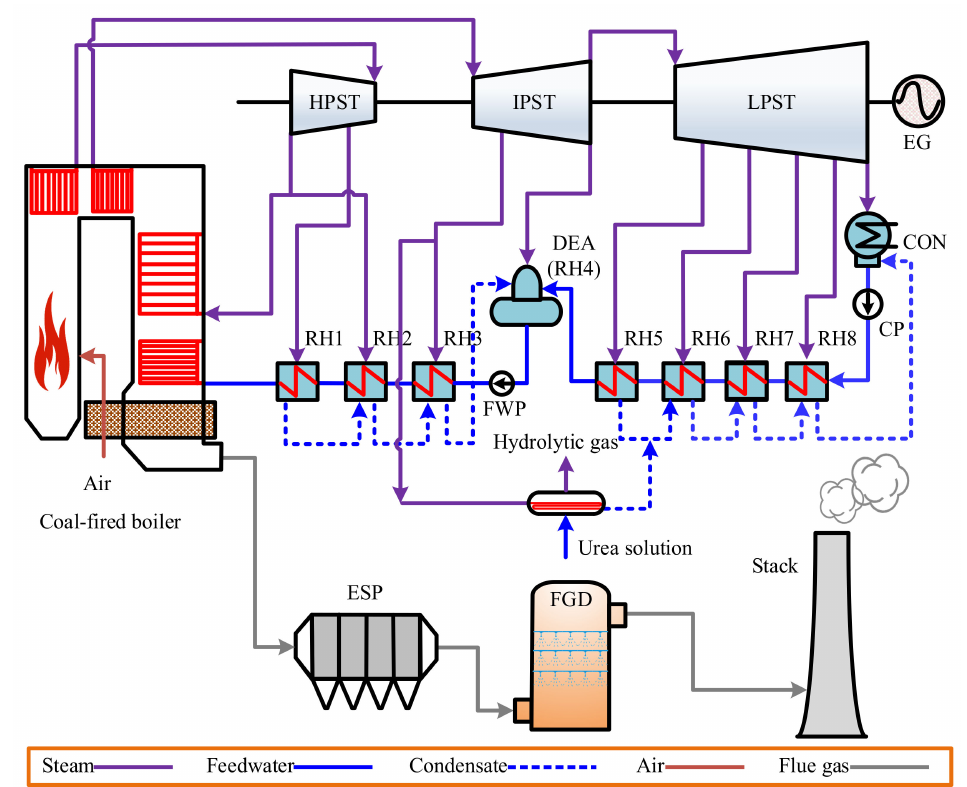
Figure 2. Diagram of the reference